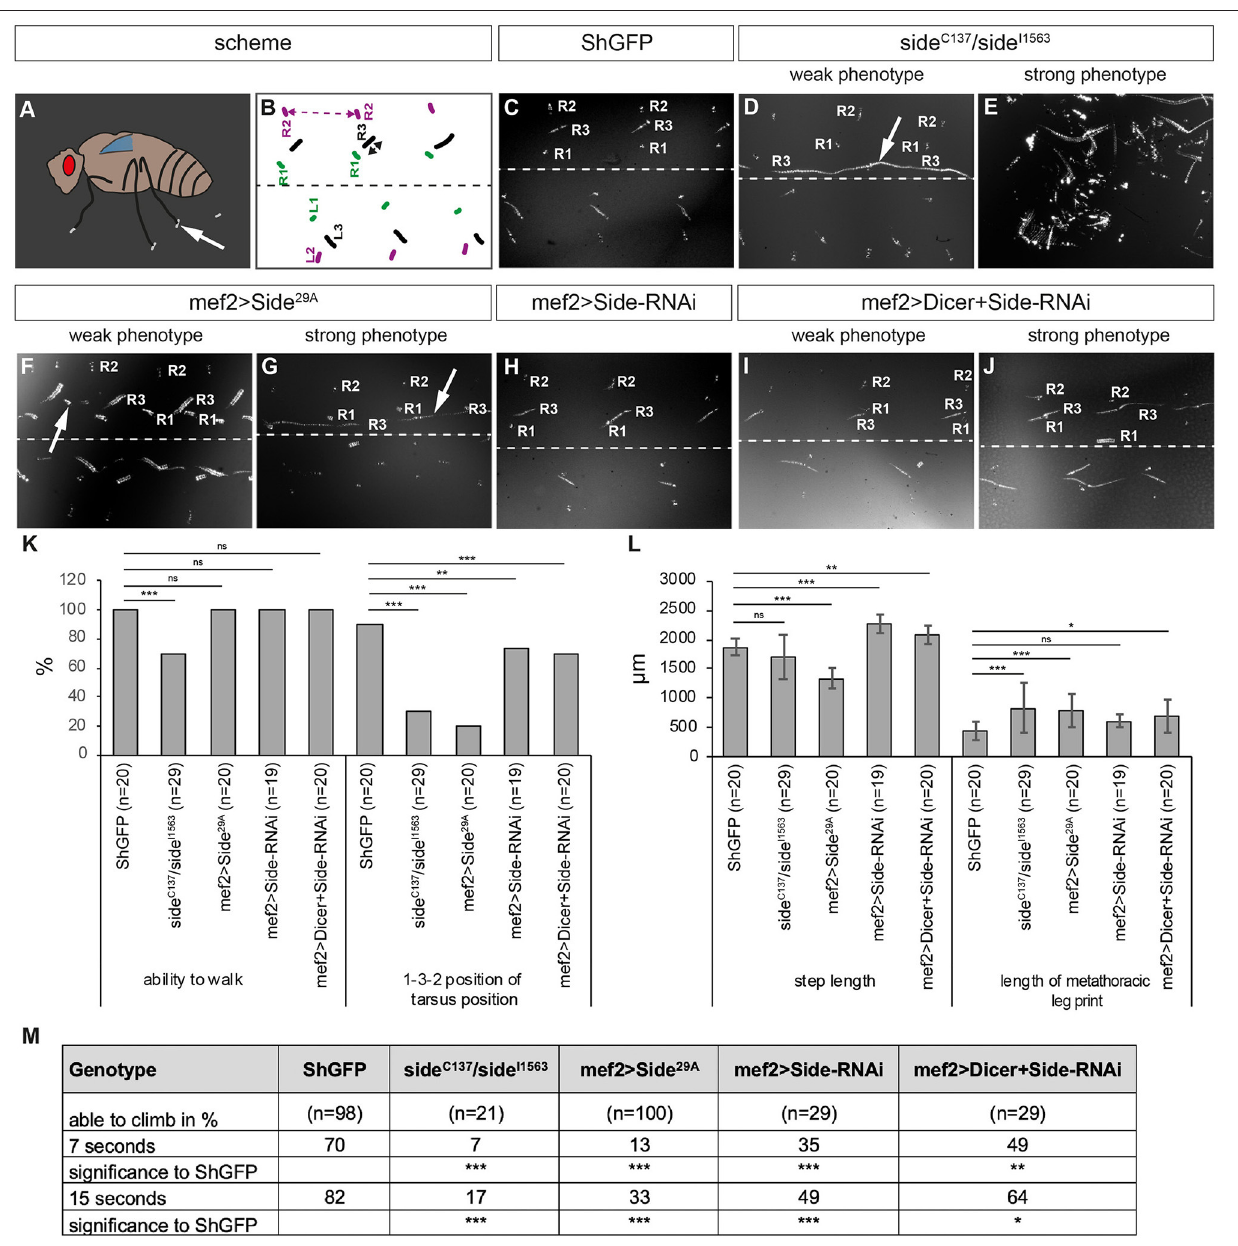
Frontiers in Neural Circuits |